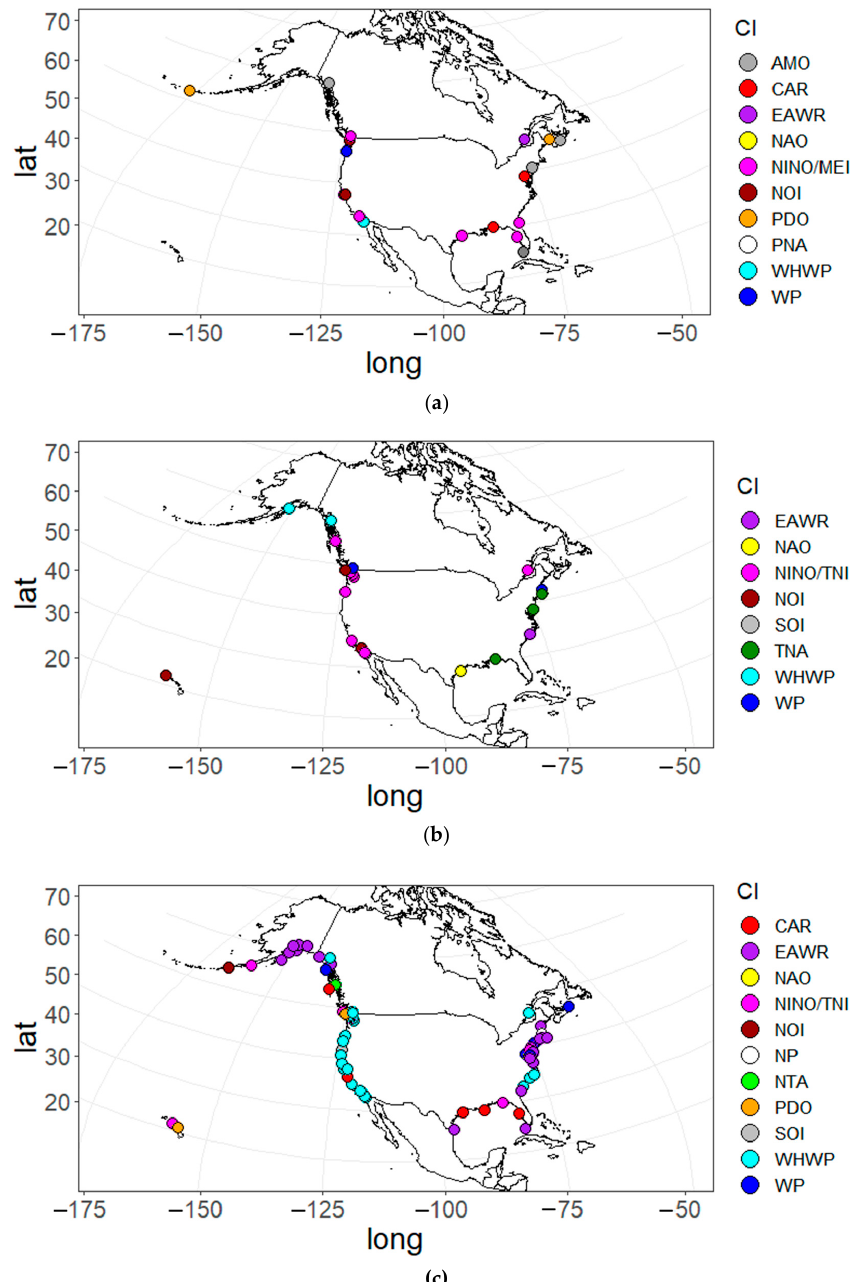
Figure 5. As in Figure 4, except for the epochs ( a ) 1948–1970, ( b ) 1971–1994, and ( c ) 1995–2018. (See Table 1 for CI abbreviations.). Table 2. Lists of the dominant CIs that correlate with mean sea level and the percent of sites where |r| >= 0.60 and the p -value <= 0.05 using a sliding window size of 60 months and lag time = 0 over